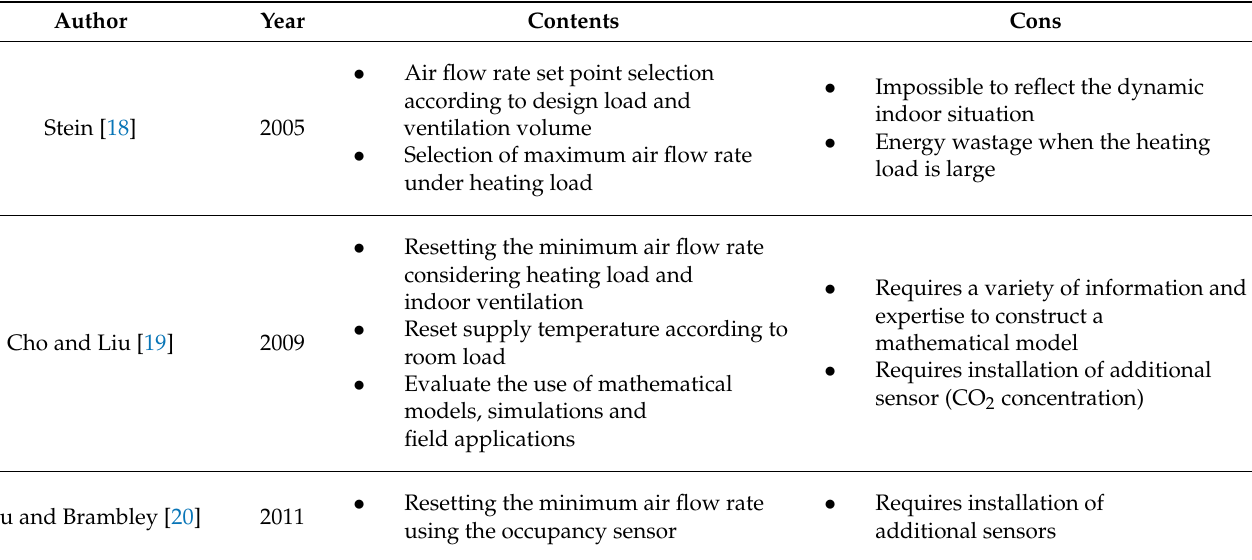
Table 1. Existing study of VAV terminal unit